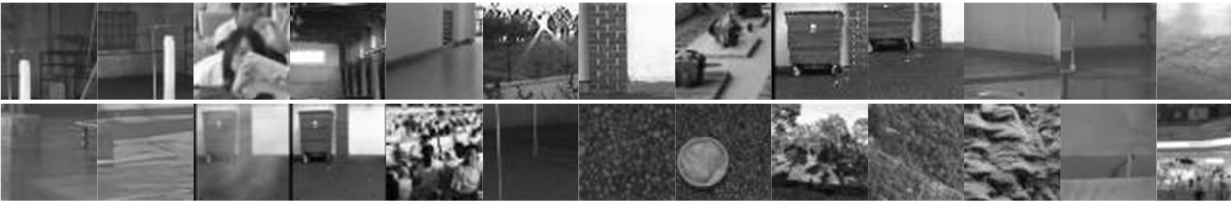
Figure 11. Positive sample examples.